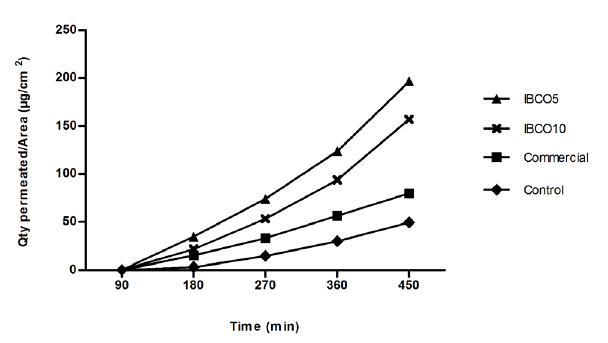
FIGURE 3 - Skin distribution of ibuprofen (IBU) in the epidermis and the dermis, 450 minutes application of cream with IBU 5% (CO), Commercial product, cream with IBU 5% and copaiba oil 5% (IBCO5) and cream with IBU 5% and copaiba oil 10% (IBCO10). *p < 0.05; **p < 0.01 in comparison with epidermis and dermis (n =